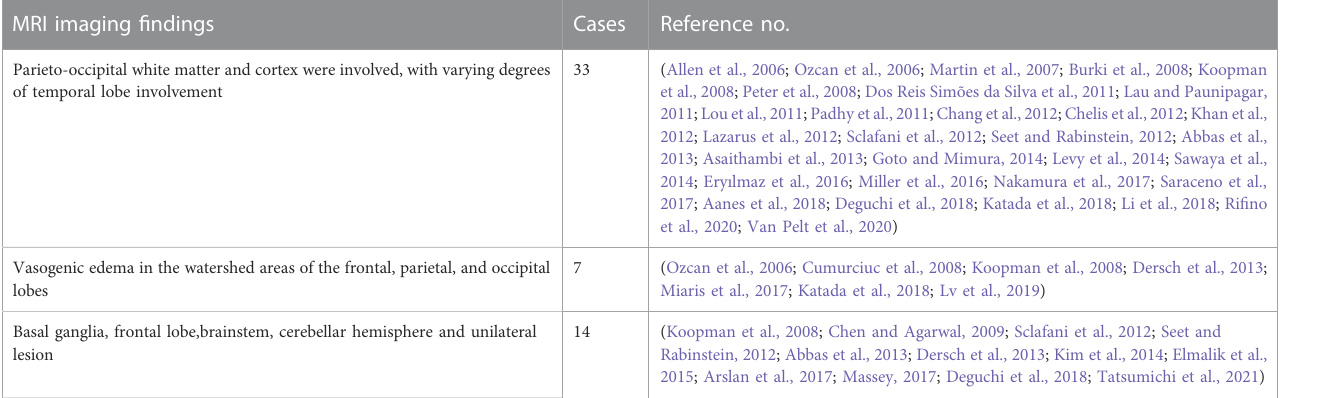
TABLE 2 MRI imaging fi ndings in PRES patients. MRI imaging fi